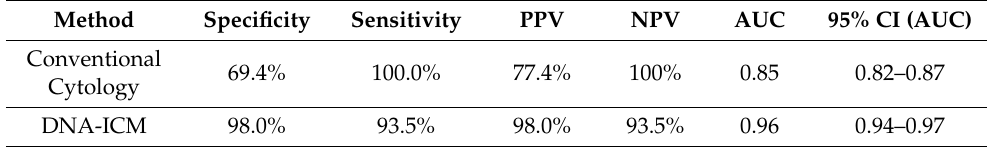
Table 3. Sensitivity, specificity, positive and negative predictive values (PPV and NPV) of cytology and DNA aneuploidy for oral potentially malignant disorders (OPMD) and OSCC.